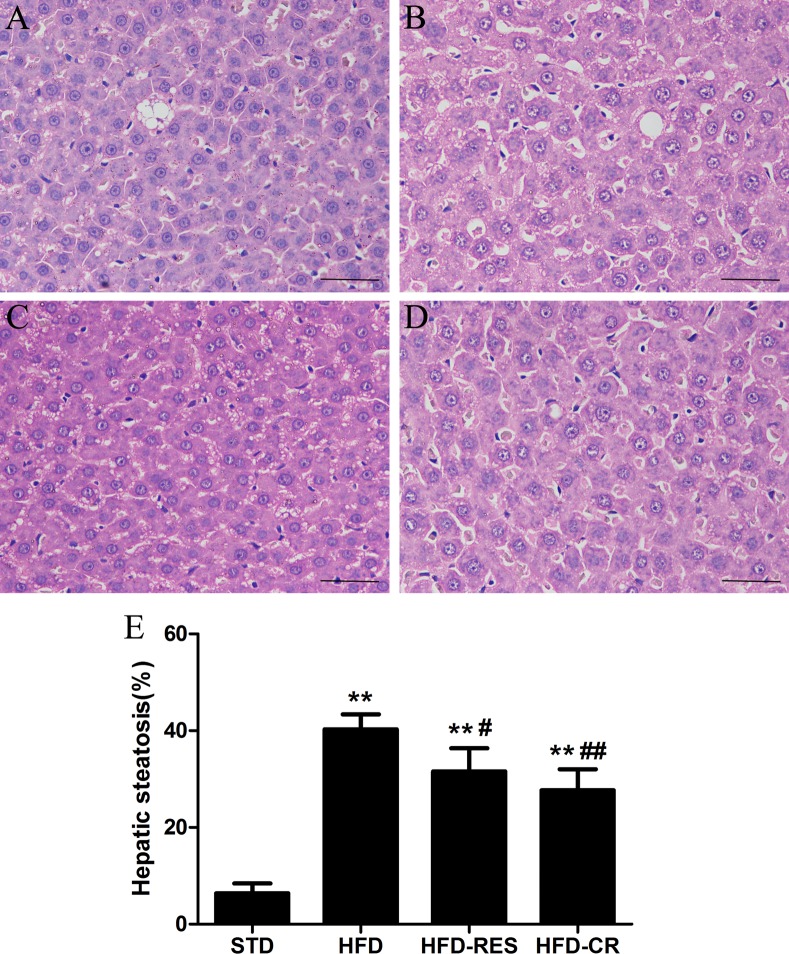
Hematoxylin and eosin staining observation of rat liver tissue (original magnification: ×400, scale bars = 50 μm).(A) STD group. (B) HFD group. (C) HFD-RES group. (D) HFD-CR group. (E) Volume density of quantitation of hepatic steatosis (n = 5 per group). **, P<0.01 compared with the STD group; #, P<0.05 and ##, P<0.01 compared with the HFD group.